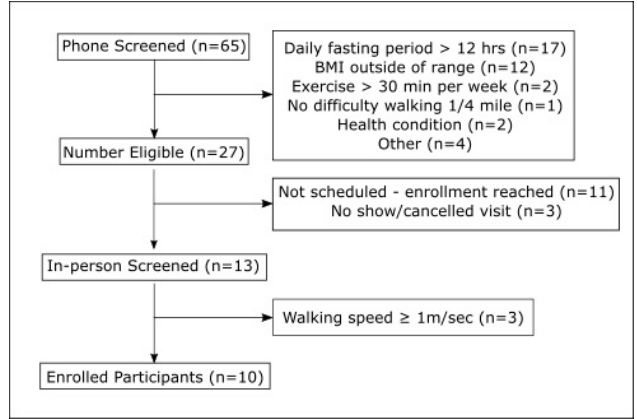
Figure 1. Participant recruitment flow. Table 1. Baseline and Follow-Up Values on All Study Measures.